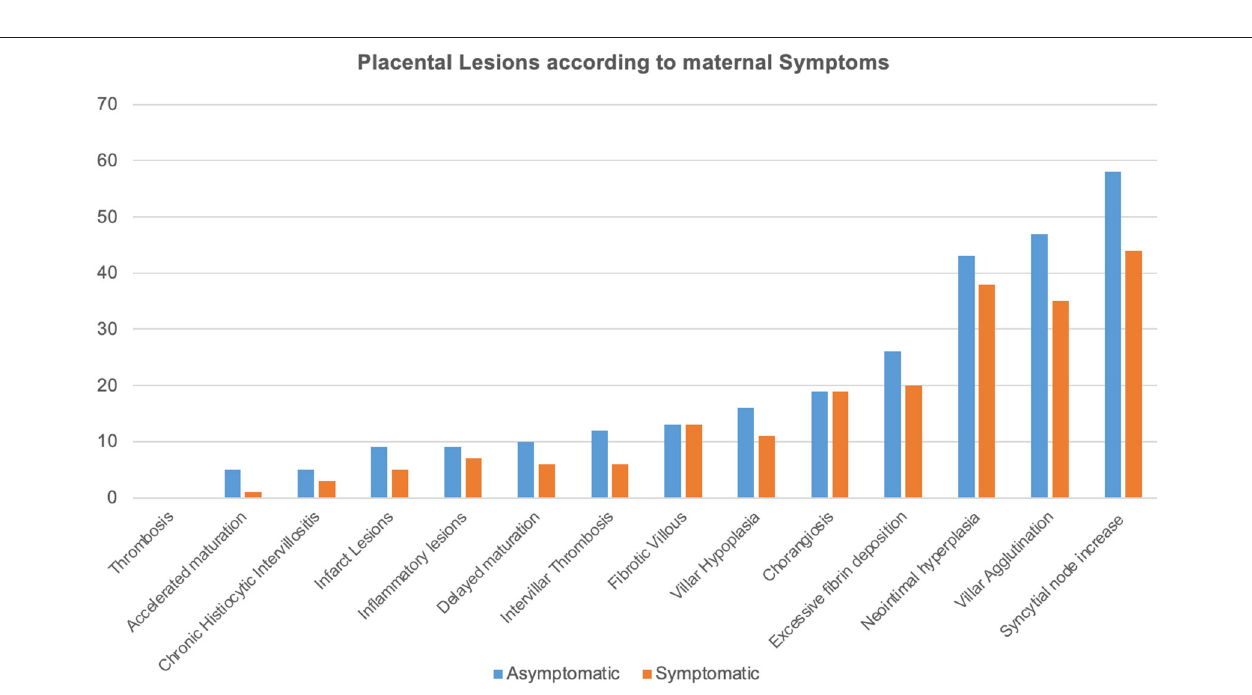
Frontiers in Medicine |